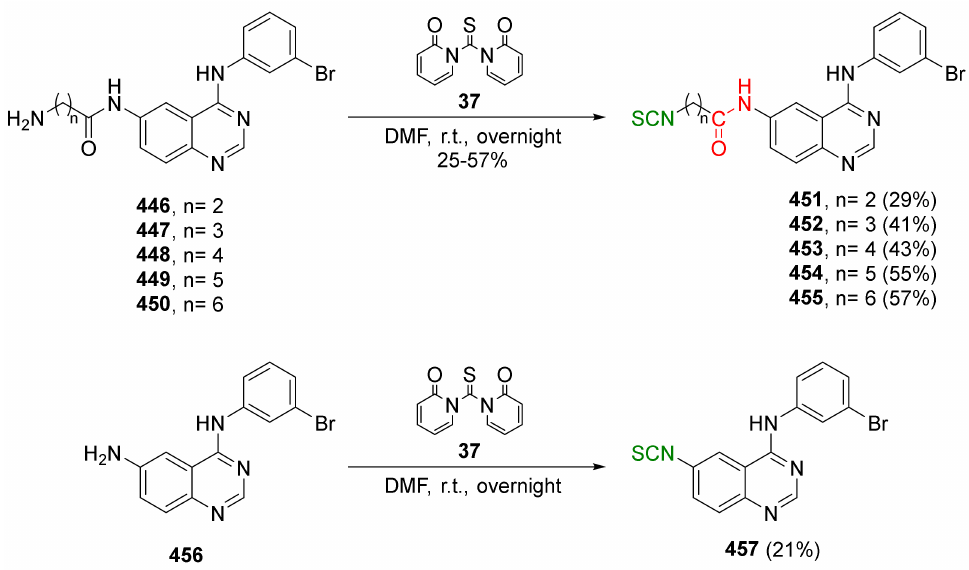
Figure 50. Synthesis of ITCs 451 – 455 and 457 . In 2019, Boehm and co-workers [264] synthesized crystalline SFN analogues 459 and 461 . Both isothiocyanates 459 and 461 were obtained in good yields, in a two-step reaction of the appropriate amine hydrochlorides 458 or 460 , and carbon disulfide in the presence of triethylamine, using hydrogen peroxide or tosyl chloride as desulfurizing agents (Figure 51).